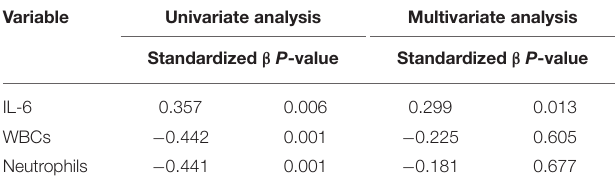
TABLE 3 | Linear regression models for SERPINA3.